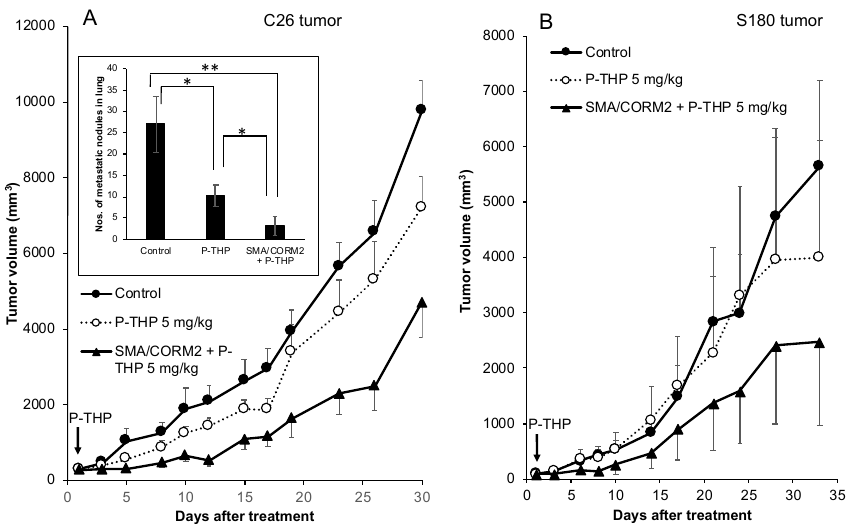
Figure 5. Augmentation of therapeutic effect of P-THP by SMA/CORM2 against C26 ( A ) and S180 ( B ) solid tumors. P-THP was injected i.v. only once at 5 mg/kg. SMA/CORM2 was applied 2 h before the P-THP injection. Inset of ( A ) showed the numbers of metastatic nodules in the lung. Data are means ± SD, n = 4–6. See text for details. * p < 0.05; ** p <